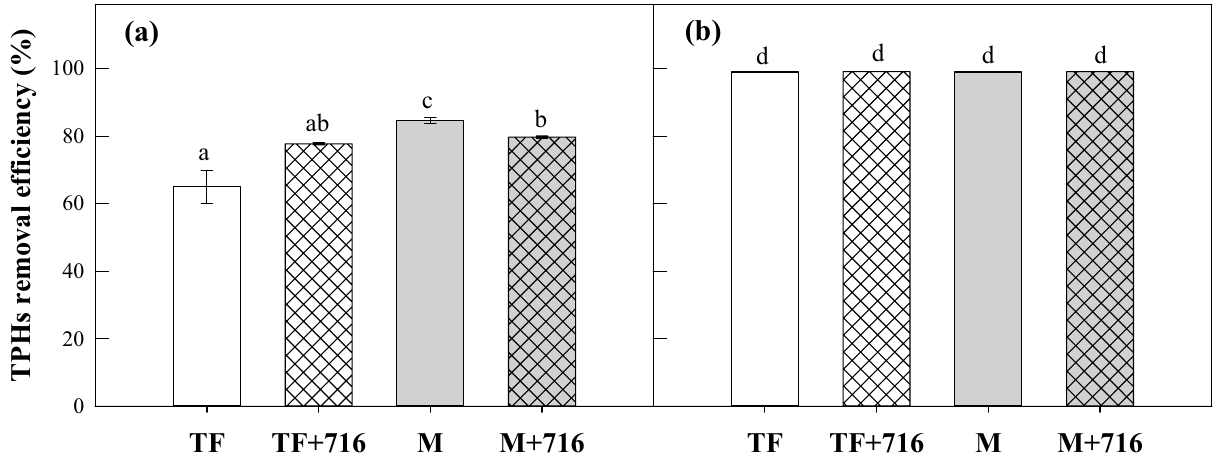
Figure 4. Comparison of the diesel-removal efficiency on days ( a ) 19 and ( b ) 59 during the rhizoremediation of diesel-contaminated soils (TF: soil planted with tall fescue; TF + 716: soil planted with tall fescue with the addition of strain TF716; M: soil planted with maize; M + 716: soil planted with maize with the addition of strain TF716). Different letters indicate a significant difference in each plot ( p <